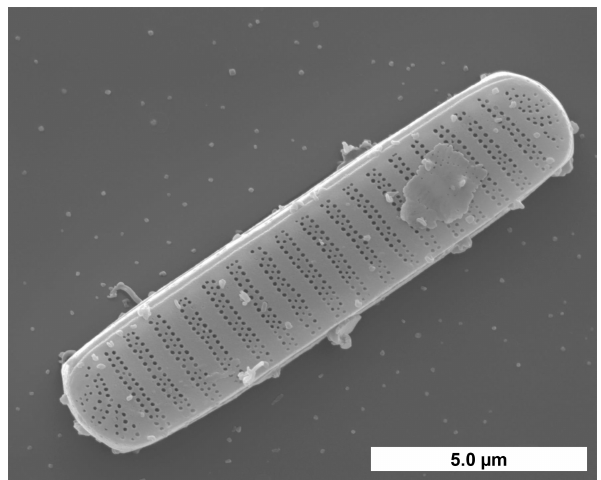
Figure 1. F. cylindrus cell visualized by scanning electron mi- croscopy. (Image courtesy of Henrik Lange and Friedel Hinz, Al- fred Wegener Institute,